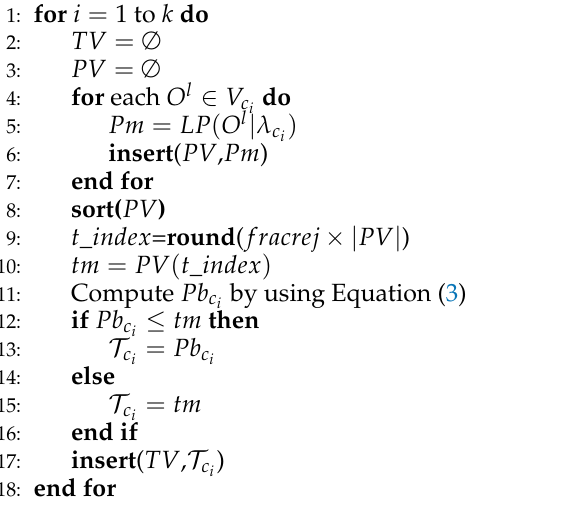
Algorithm 4 applies HMM forward algorithm, forward ( O l , λ c